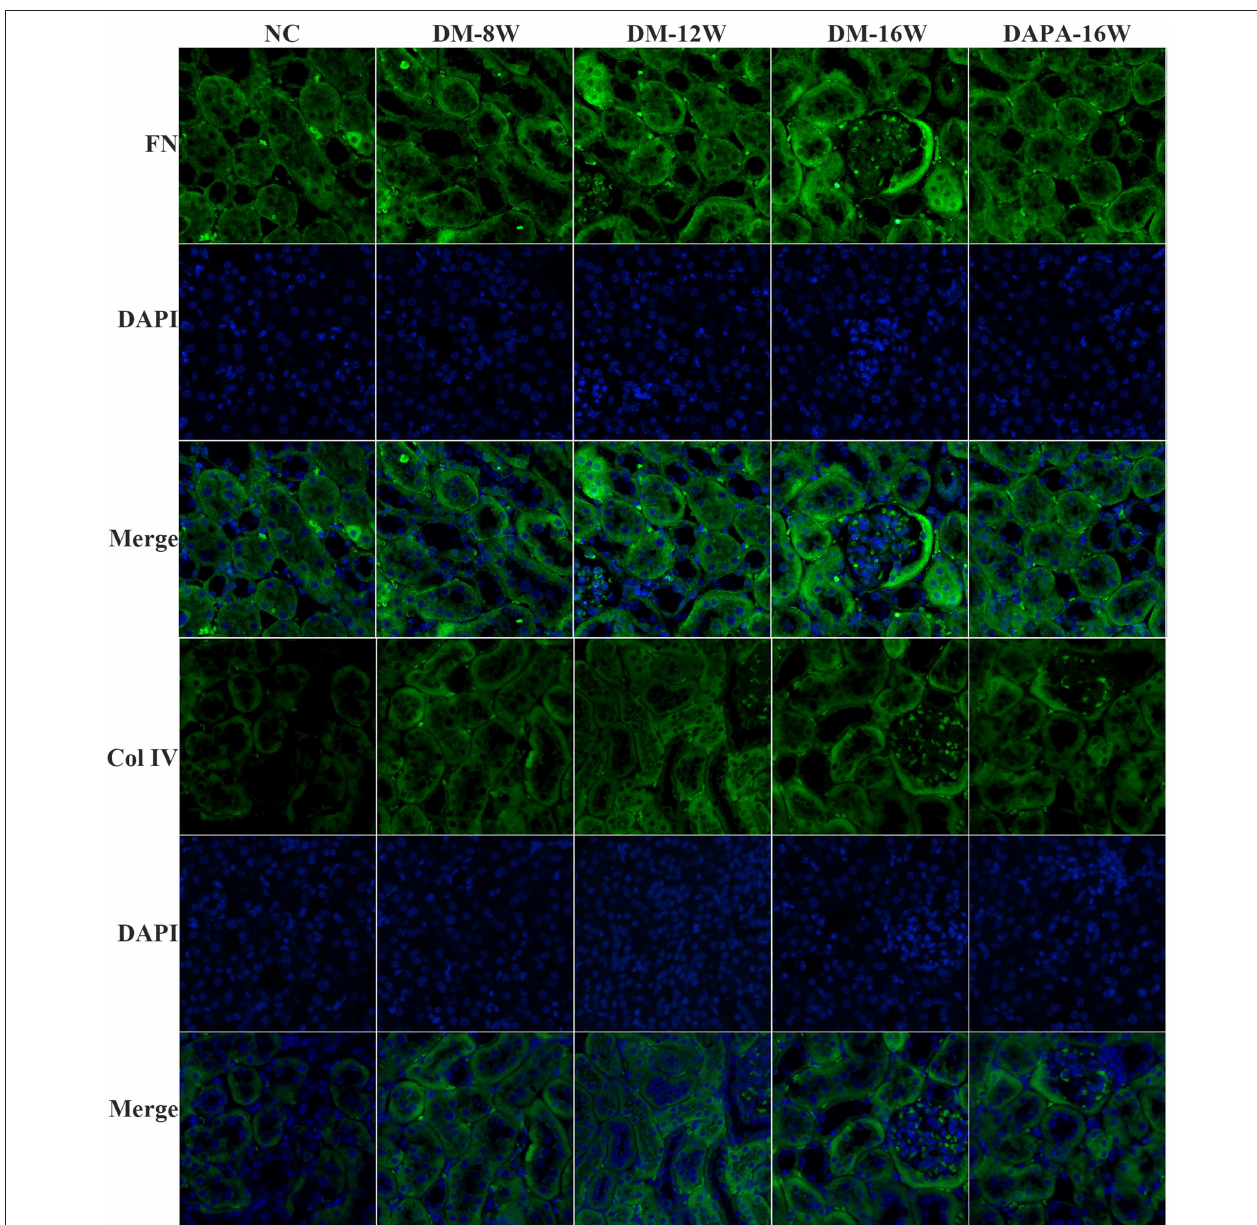
FIGURE 4 | DAPA prevents renal TIF in diabetic mice. Representative images of immunofluorescence staining for Col IV and FN in tubular areas of diabetic mice. Original magnification, 200 ×